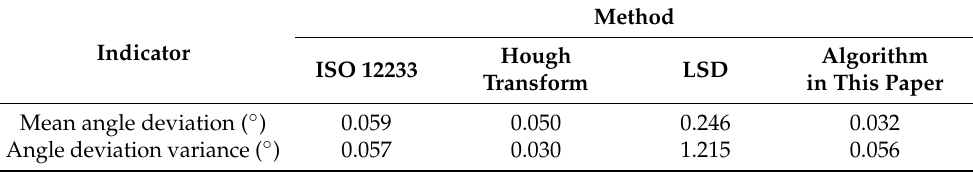
Table 1. Mean and variance of the edge angle deviation of the test results by different method.